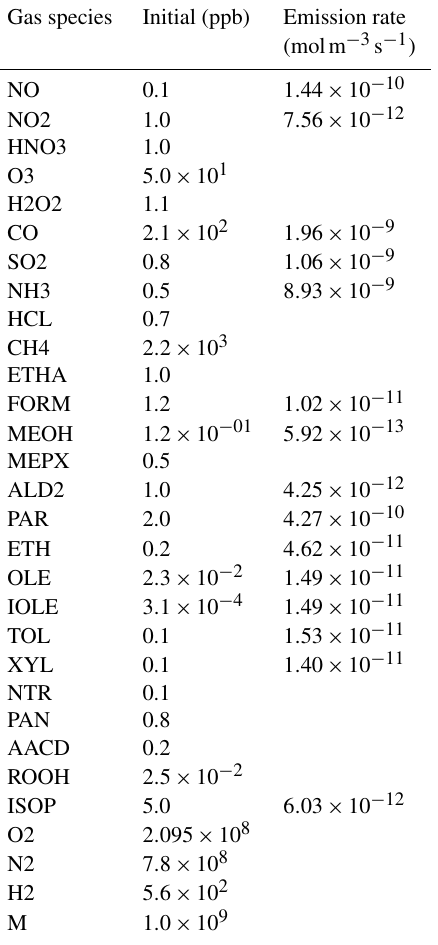
Table 10. Initial conditions and emission fluxes for gas-phase species for box model simulations.